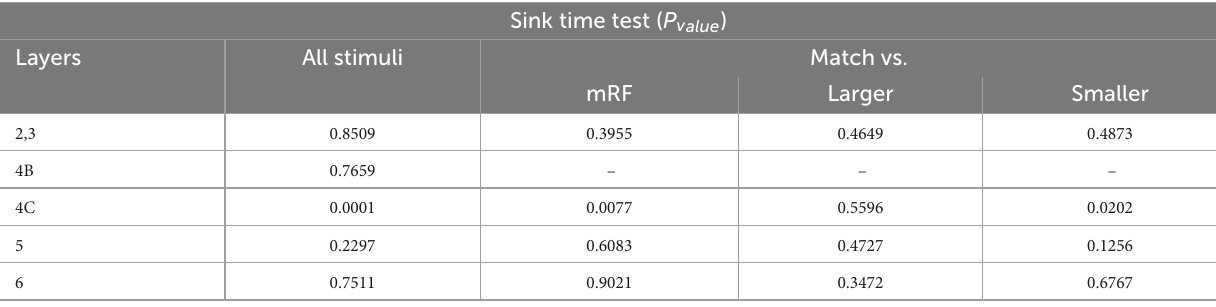
TABLE 4 The statistical test in each layer for sink time analysis.